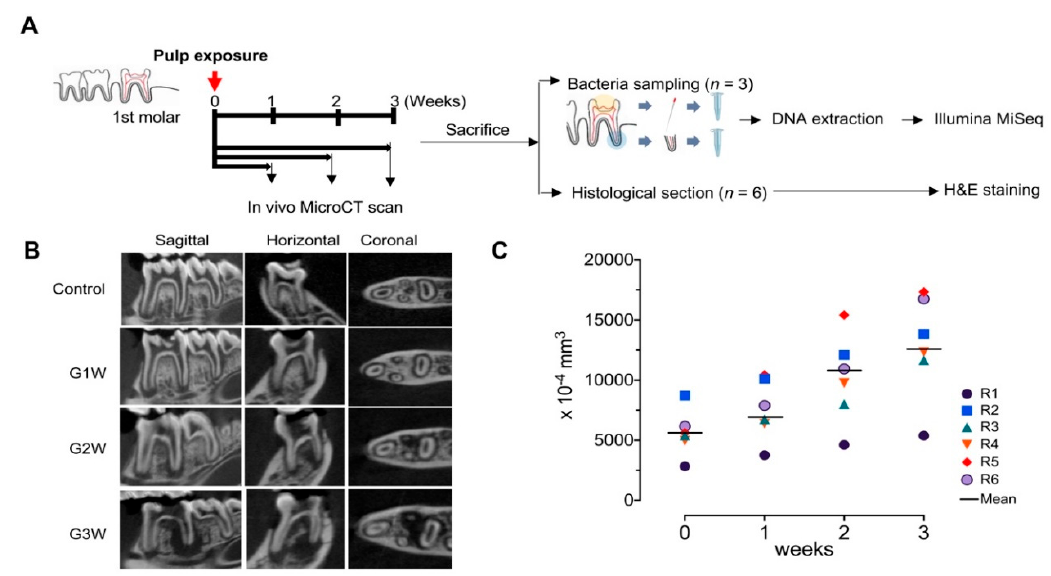
Figure 1. ( A ) Scheme of the animal experiment in this study. ( B ) Representative in vivo micro-computed tomography (micro-CT) images for three different axes for the chronological changes of the pulp-exposed lower first molar of rat. ( C ) Change in the volume of the periradicular radiolucent area for each rat of the G3W group during the three-week observation.